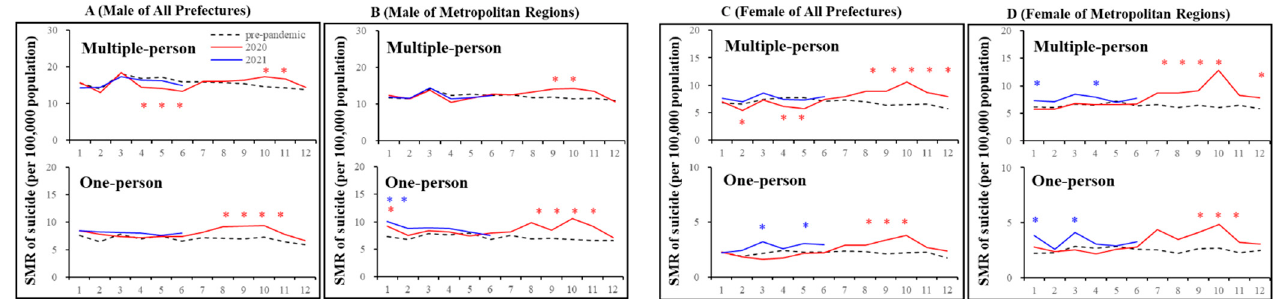
Figure 6. Temporal fluctuations in monthly SMR-S disaggregated by gender, household condition, and regional factors during the COVID-19 pandemic period (2020–2021) compared to the average of SMR-S for the same month during the pre-pandemic period (2017–2019). Dotted black, red, and blue lines indicate the average of SMR-S for ( A ) males from all 47 prefectures, ( B ) males from metropolitan regions, ( C ) females from all 47 prefectures and ( D ) females from metropolitan regions. Ordinates indicate the SMR-S (per 100,000 people), and abscissas indicate the month. * p < 0.05, significant change using a linear mixed-effects model with Tukey’s multiple comparison. Red and blue asterisks indicate significant changes in SMR-S in 2020 and 2021, respectively, compared to the average SMR-S of the same month during the pre-pandemic period.